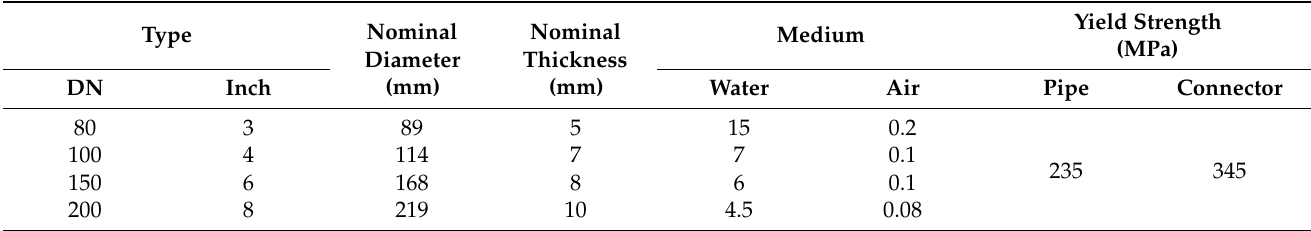
Table 2. Geometric and material parameters for prototype types.